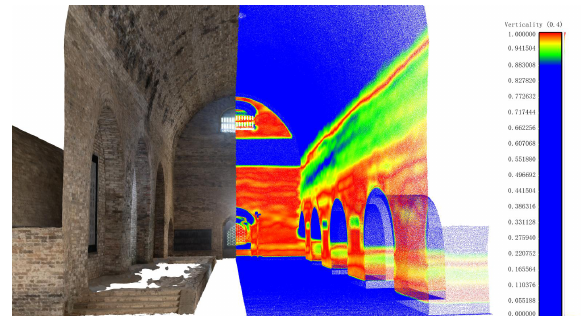
Figure 8. Visual of the deformation areas. The color scale was obtained by calculating the ‘verticality’ of point cloud (radius =